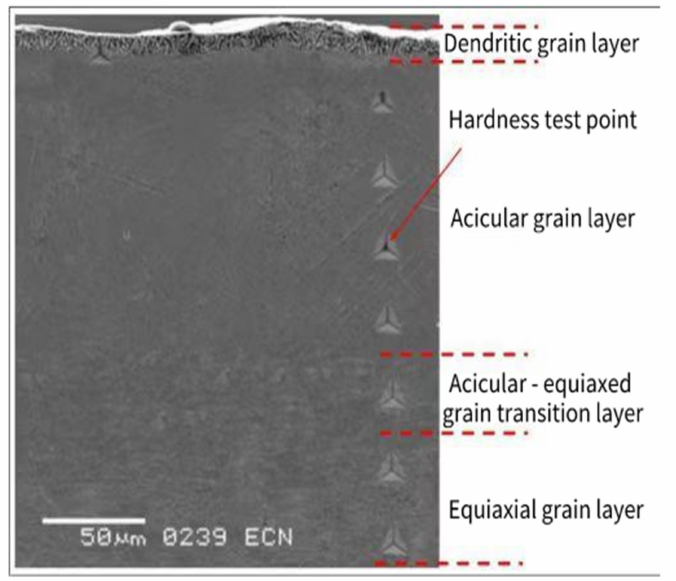
Figure 12. Metallographic organisation changes [24]. Table 7. Regression analysis coefficients of surface roughness